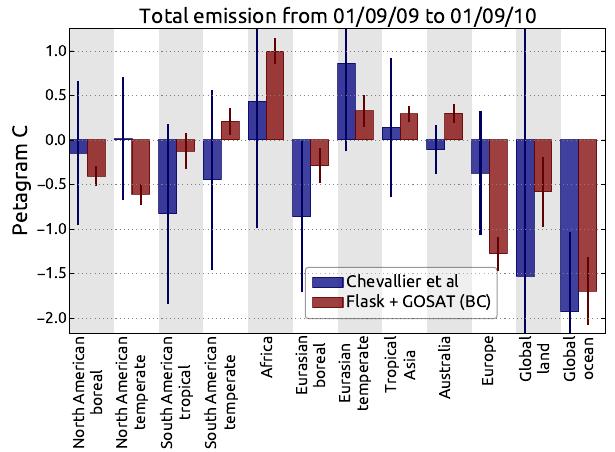
Fig. 16. Comparison of our optimized fluxes over aggregated land areas with those obtained by Chevallier et al. (2011) after assim- ilating TCCON X CO . Both sets of fluxes are without fossil fuel 2